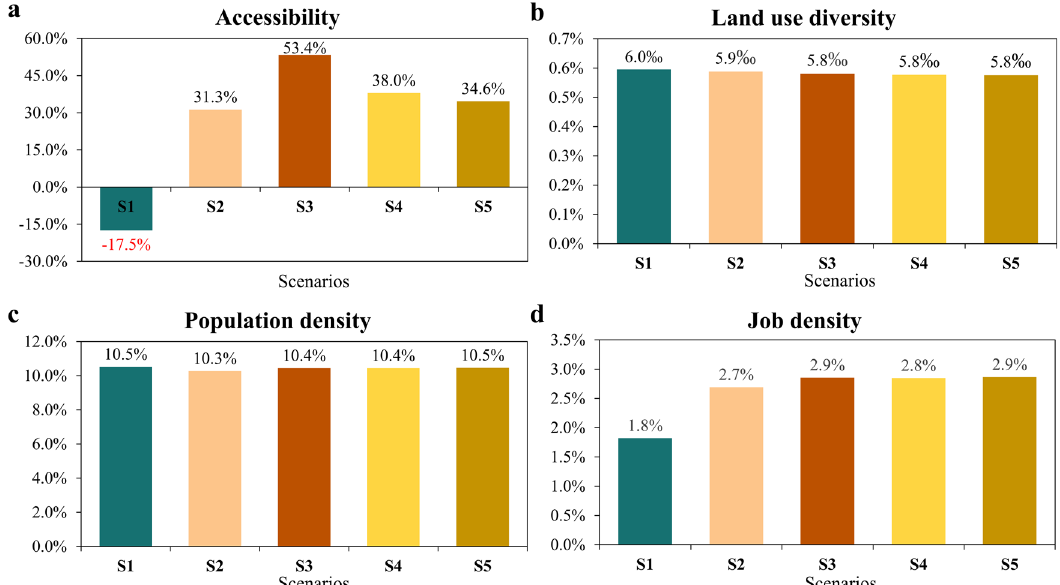
Fig. 2 The impact of SAVs on land-use system. The impact of SAVs pricing scenarios (relative to S0) on ( a ) accessibility, ( b ) land-use diversity, ( c ) population density, and ( d ) job density. Data labels show the percentage change relative to Scenario S0. Different SAVs pricing scenarios are represented in different